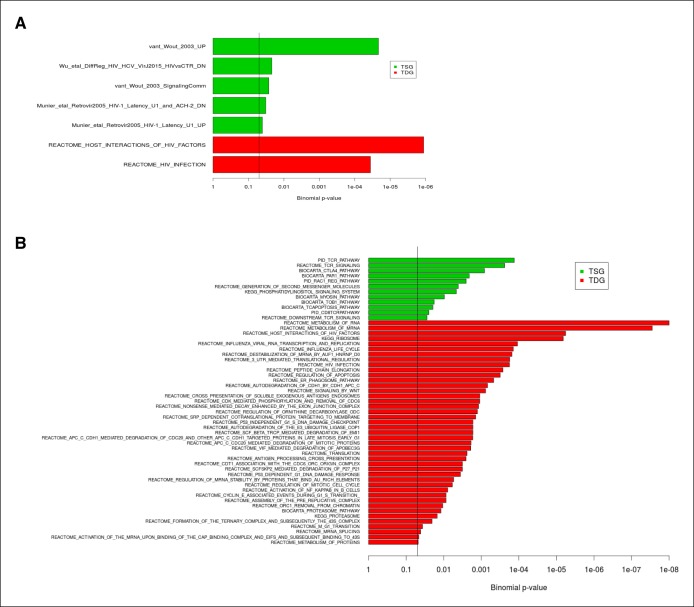
Enrichment of TSG and TDG in publicly available datasets of differentially expressed genes identified in HIV infection and replication experiments.(A) The enrichment analysis with 48 publicly available differentially expressed gene datasets identified in HIV and replication experiments and 14 HIV relevant pathways from MSigDB are shown. (B) The functional annotation by the MSigDB canonical pathways (set c2.cp) is depicted. Twelve significantly TSG enriched gene sets and 43 significantly TDG enriched gene-sets have been identified. P-values are Bonferroni adjusted for multiple testing. The vertical line indicates FDR = 0.05. FDR, false discovery rate; HIV, human immunodeficiency virus; MSigDB, Molecular Signatures Database; TDG, Tat downregulated genes; TSG, Tat stimulated genes.